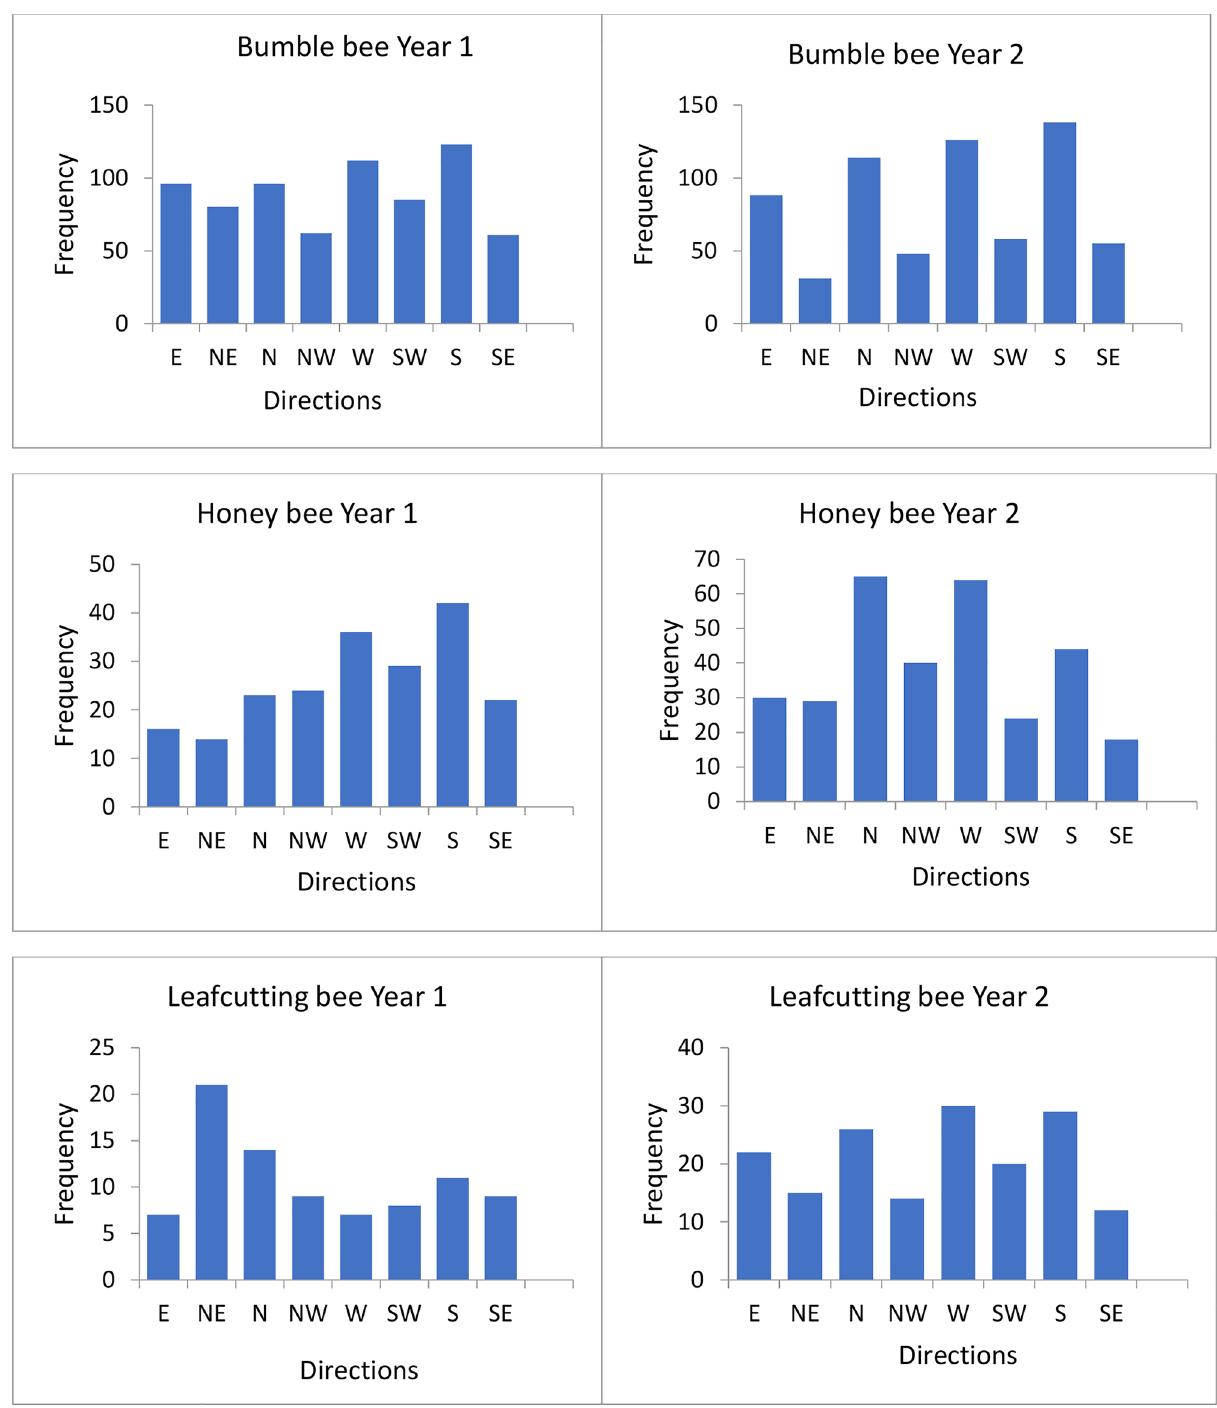
Figure 2. Frequency distributions of directions traveled between consecutive racemes for each bee species each